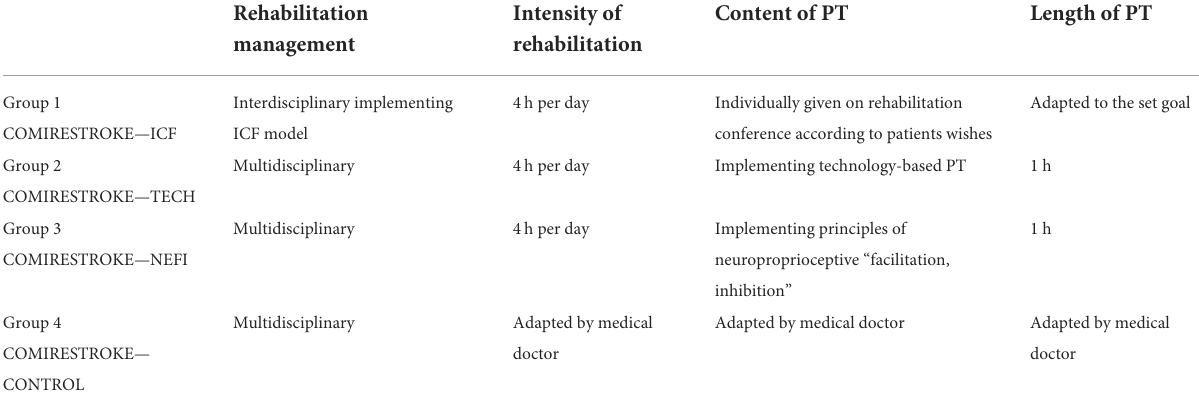
TABLE 2 Main differences in the intervention between four